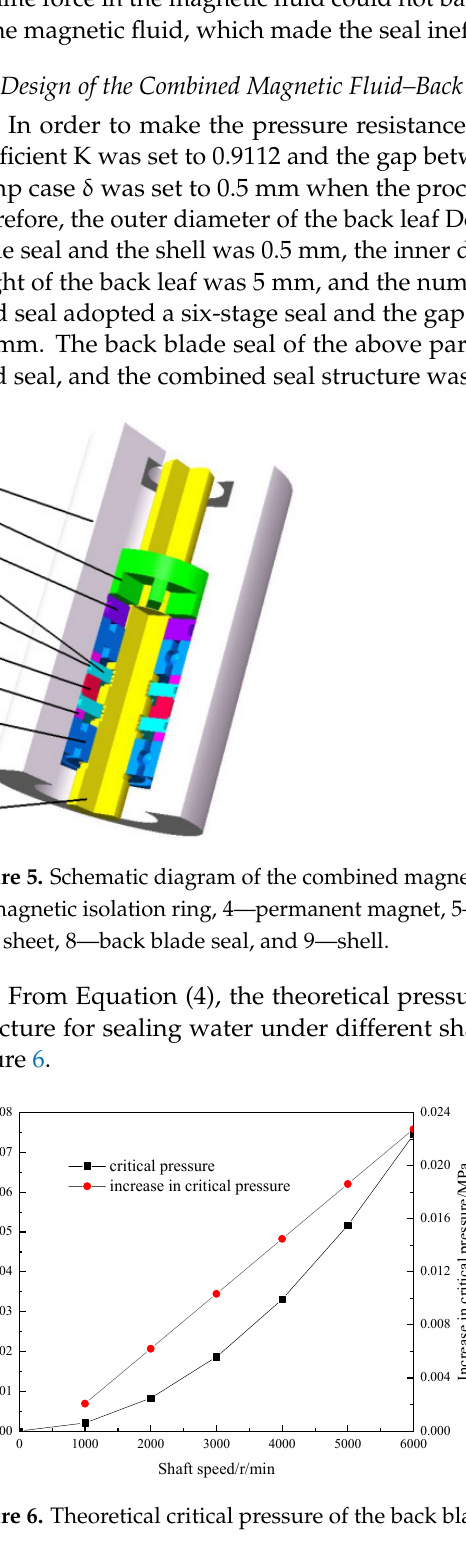
Figure 4. The process of wastage of the magnetic fluid film during a long period.